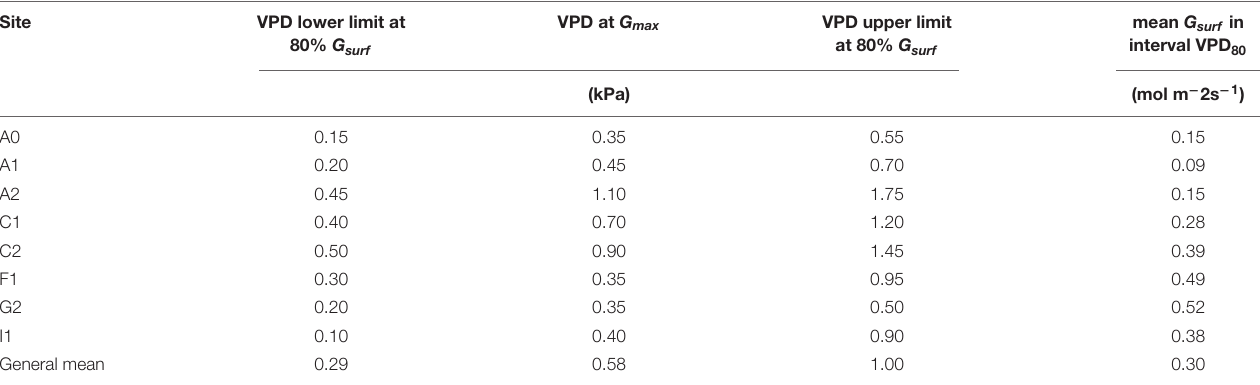
TABLE 4 | Mean values of VPD at G max and at the lower and upper limit of the VPD 80 interval, i.e., when G surf = 80% of G max .